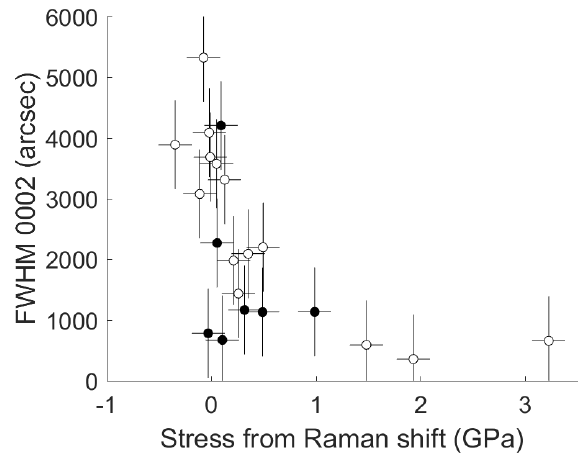
Figure 4. Crystal quality in AlN layers versus stress deduced from Raman shift. Full dots indicate samples with cracks. Standard deviation is indicated.